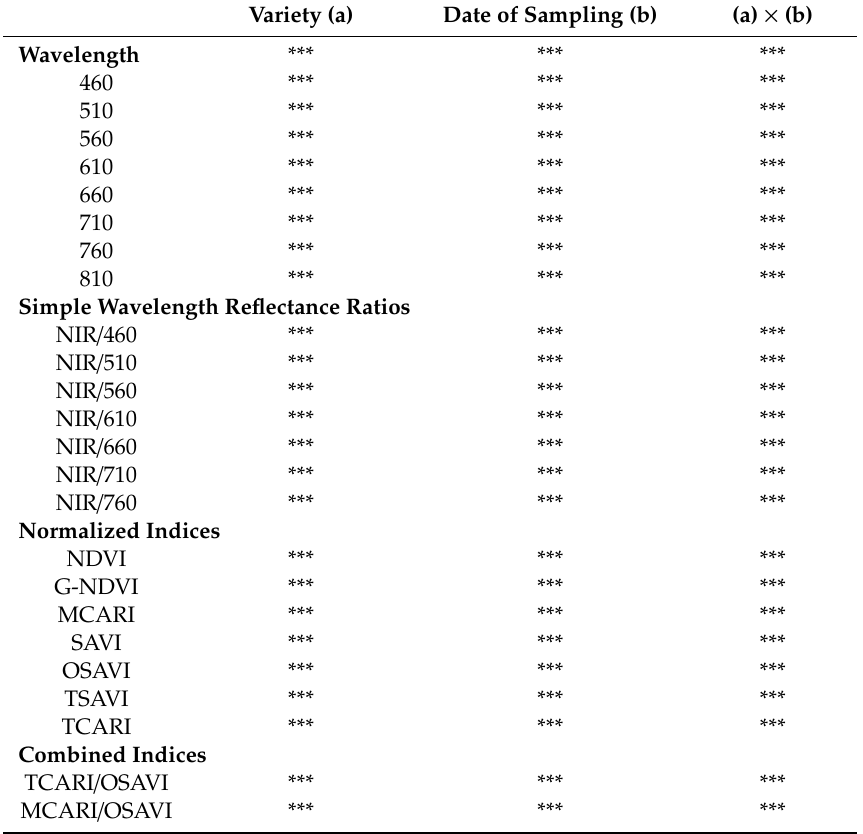
Table 6. Experiment 5#. Statistical significance of each of the factors (variety, and date of sampling) and of the interaction by ANOVA. * p < 0.05, ** p < 0.01, *** p < 0.001, NS not